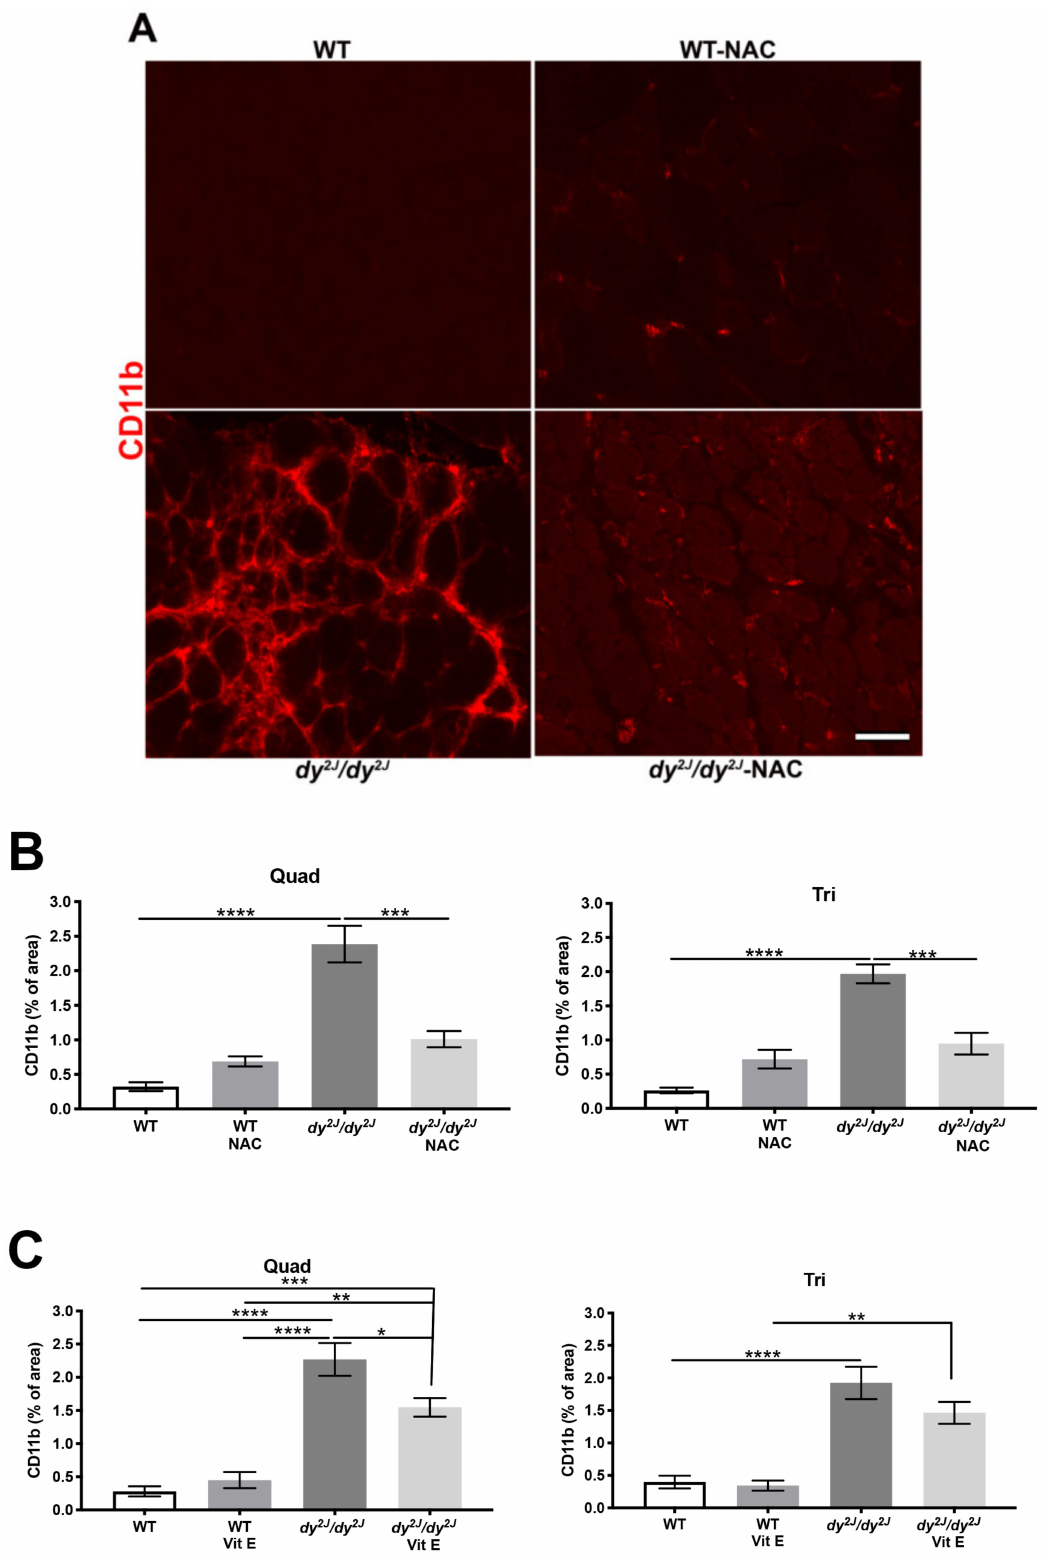
Figure 5. ( A ) Representative CD11b-stained quadriceps muscle sections; ( B ) Quantification of CD11b-stained areas in 7 WT, 9 WT NAC, 5 dy 2J / dy 2J , 6 dy 2J / dy 2J NAC quadriceps and triceps muscles; ( C ) CD11b-positive areas in 5 WT, 6 WT vit E, 5 dy 2J / dy 2J , 5 dy 2J / dy 2J vit E quadriceps and triceps muscles. * p < 0.05, ** p < 0.01, *** p < 0.001 and **** p < 0.0001. Bar: 50 µ